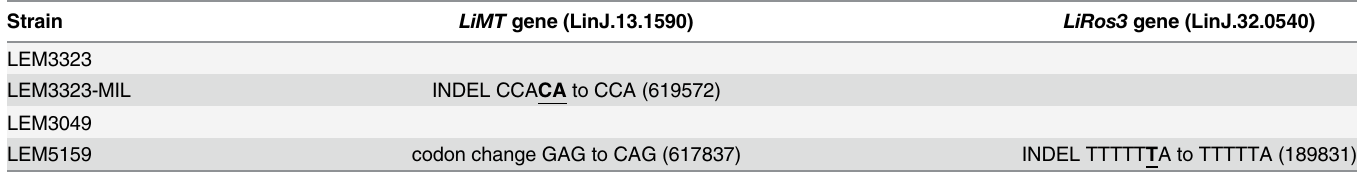
Table 2. Coding sequence mutations within the LiMT and LiRos3 MIL-transporting complex, identified in the L . infantum MIL-resistant strains.